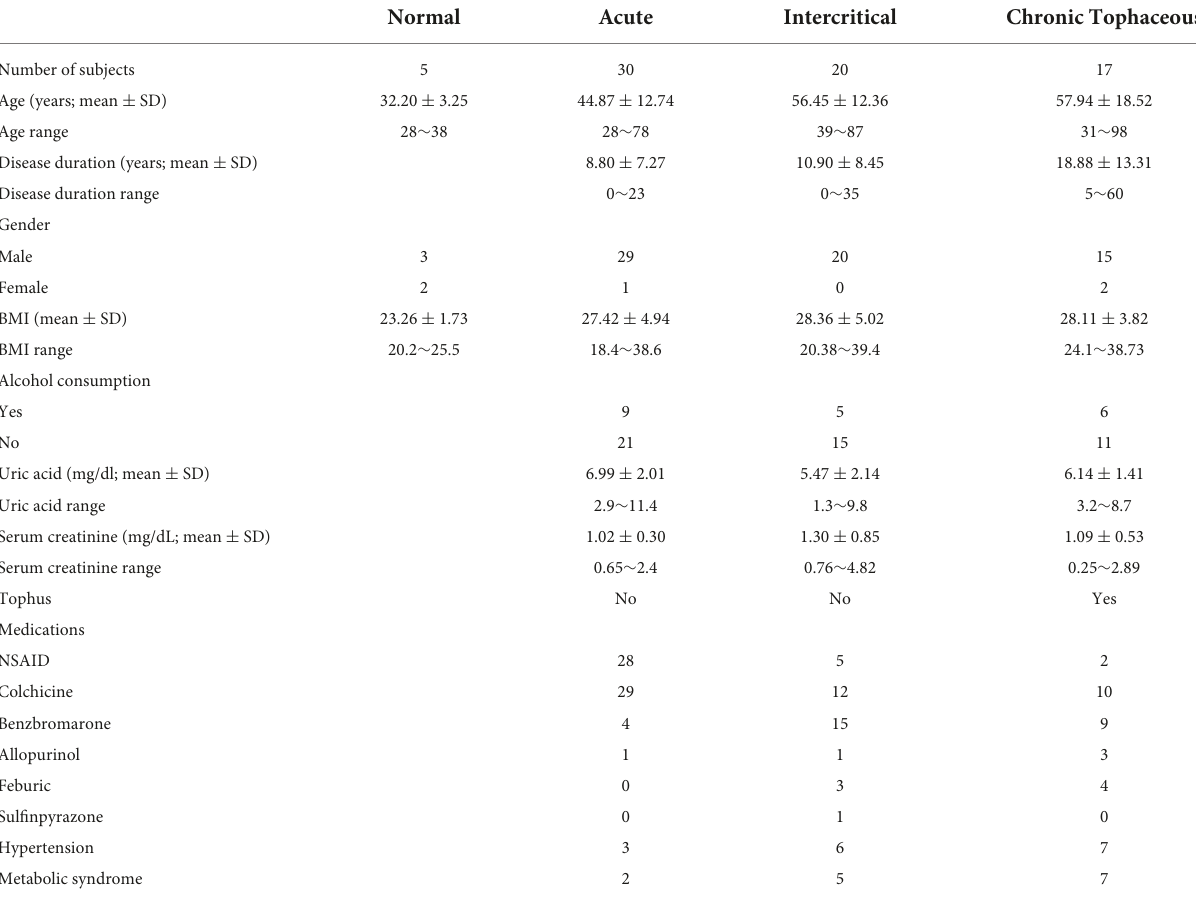
TABLE 3 Clinical characteristics of patients with